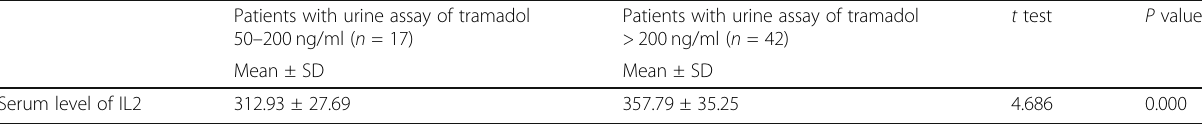
Table 4 Classification of patients according to level of tramadol in urine assay and its relation to serum level of IL-2 in them Patients with urine assay of tramadol 50 – 200 ng/ml ( n = 17)